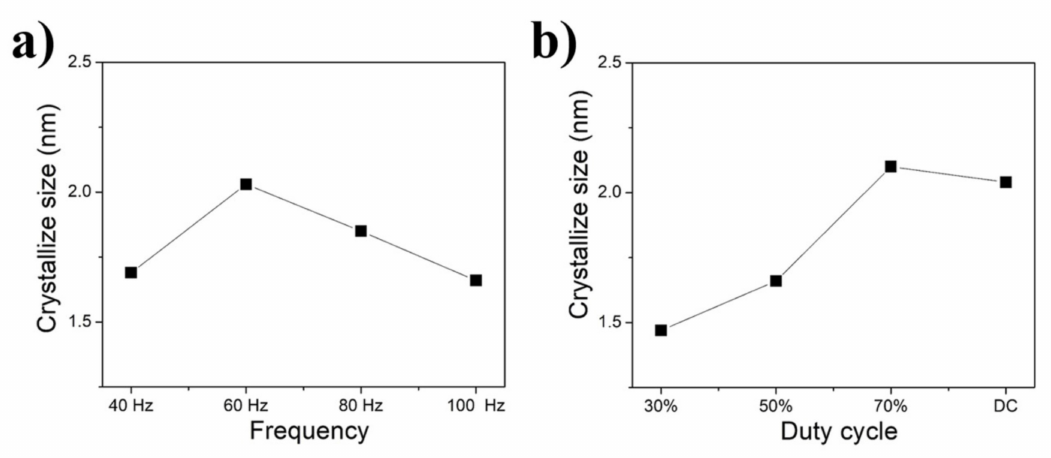
Figure 7. Effect of frequency and duty cycle on the crystallite size of the coatings ( a ) varying by frequency at 50% duty cycle, ( b ) varying by duty cycle at frequency of 100